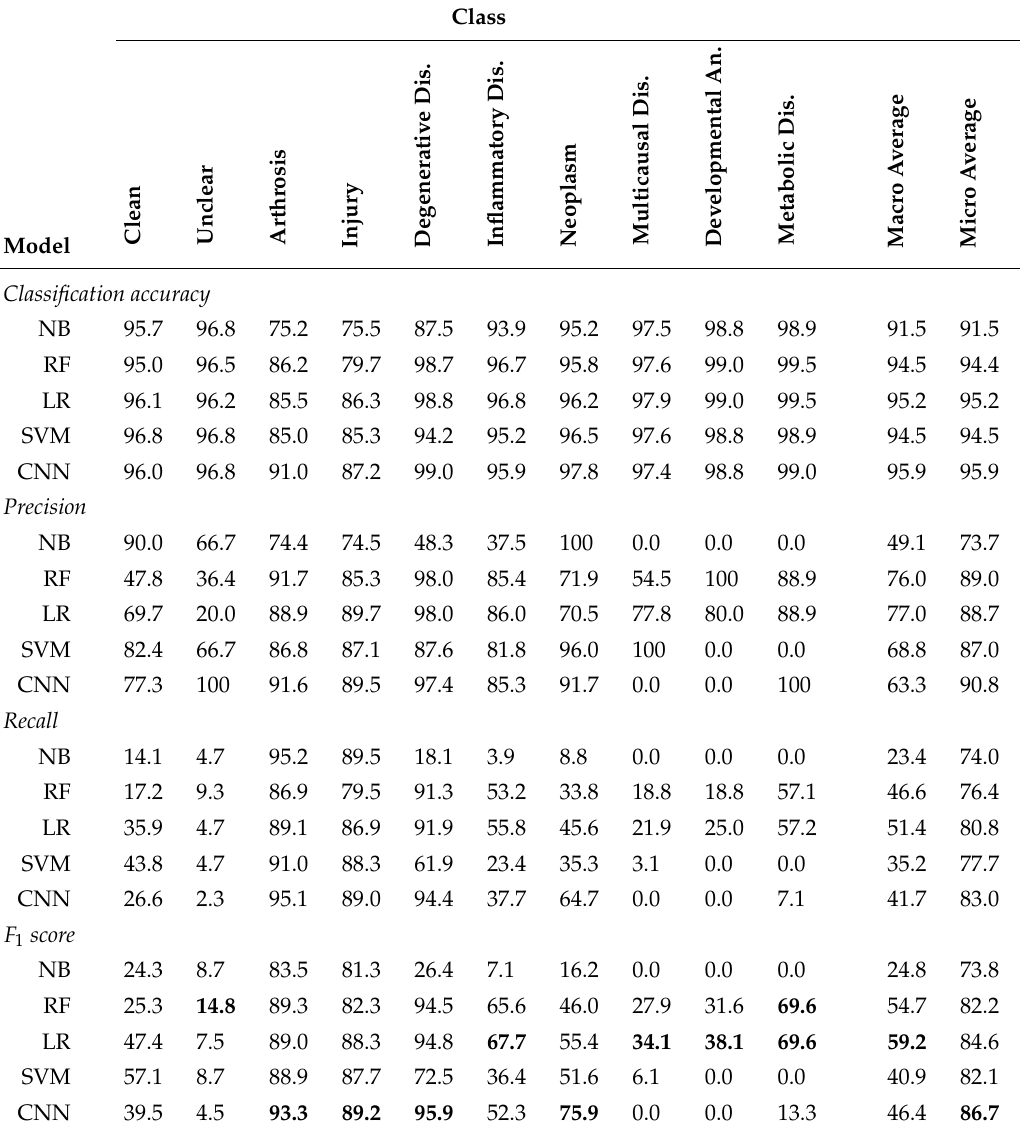
Table 5. Detailed results (classification accuracy, precision, recall, F 1 score) for NB, RF, LR, SVM, and CNN models for the 10 knee condition labels. The last two columns show the micro- and macro-averaged performance on the selected evaluation metric over all 10 classes. The results are obtained via nested 10-fold